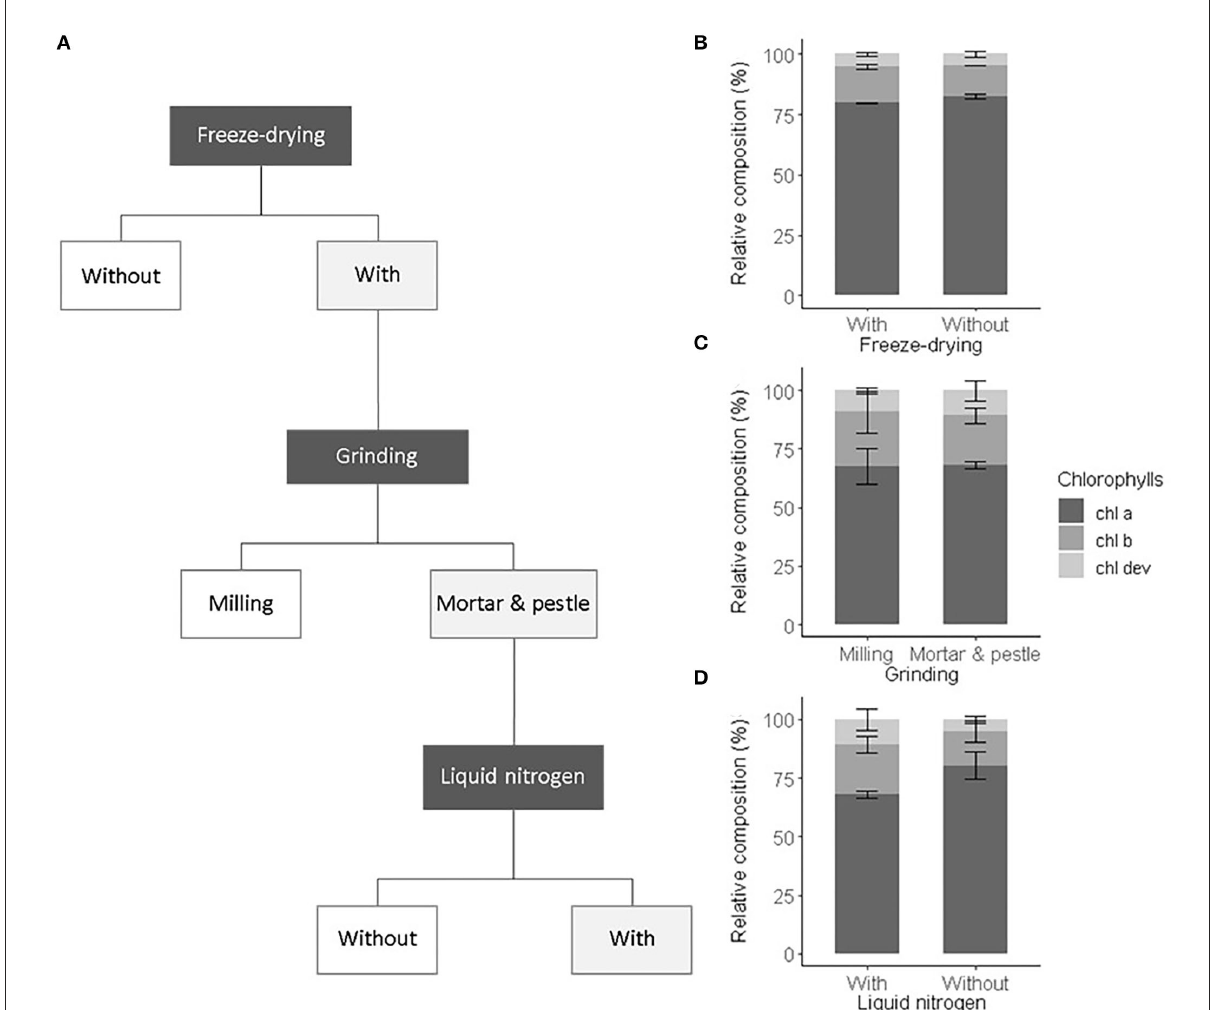
FIGURE1 Sample preparation procedure and its impact on the chlorophyll composition. (A) Selected preparation steps (light gray boxes) and the relative composition of chlorophylls including chl a (dark gray), chl b (gray), and chl dev (light gray) associated with (B) freeze drying, (C) grinding, (D) with or without liquid nitrogen. Error bars correspond to the standard deviation ( n =